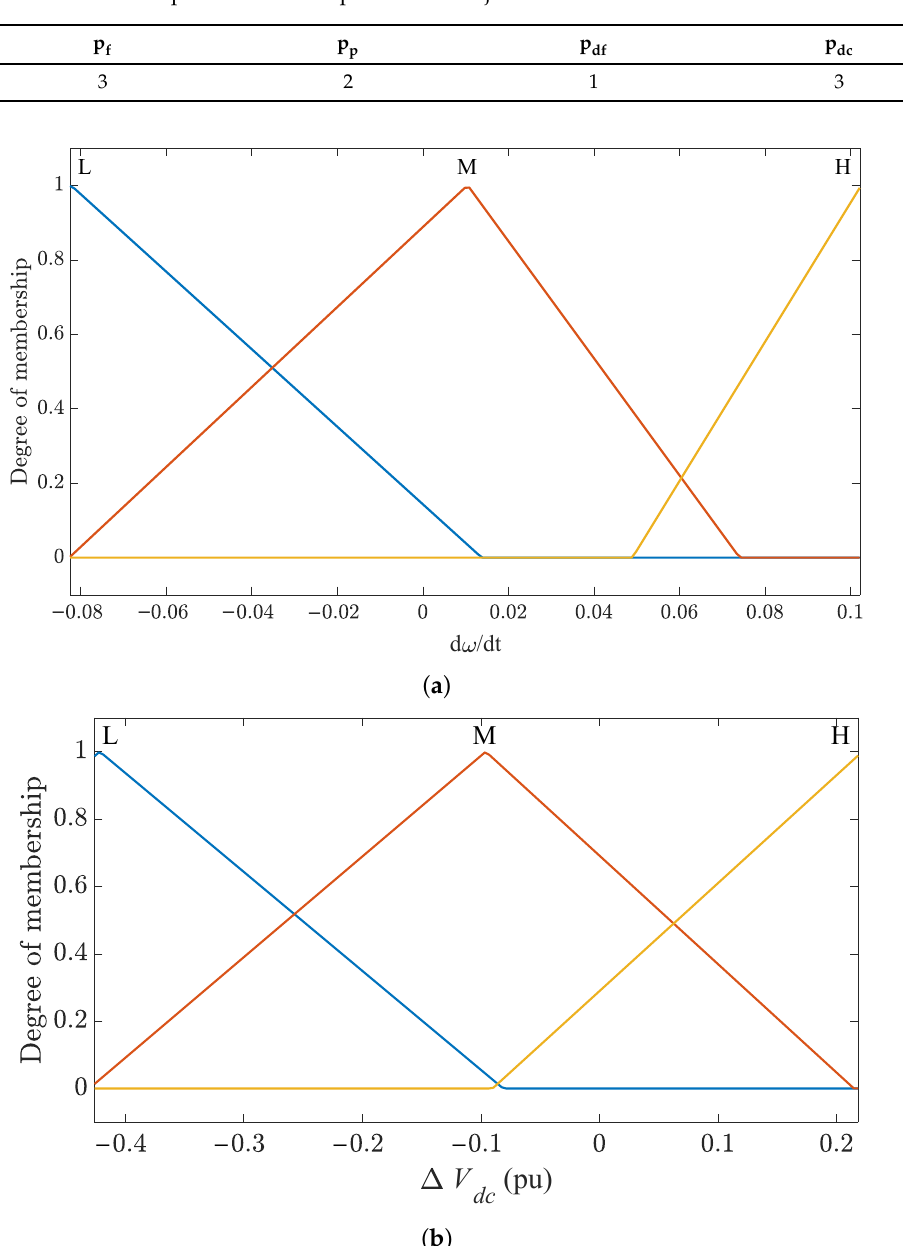
Table 3. The initial penalties of the optimization objective function.